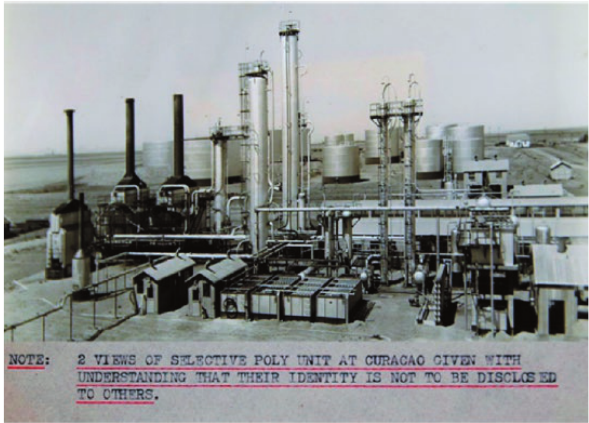
Figure 3. First Polymerization Unit in Curaĉao Refinery circa 1939. Reproduced from ACS Catalysis 2018 , 8,